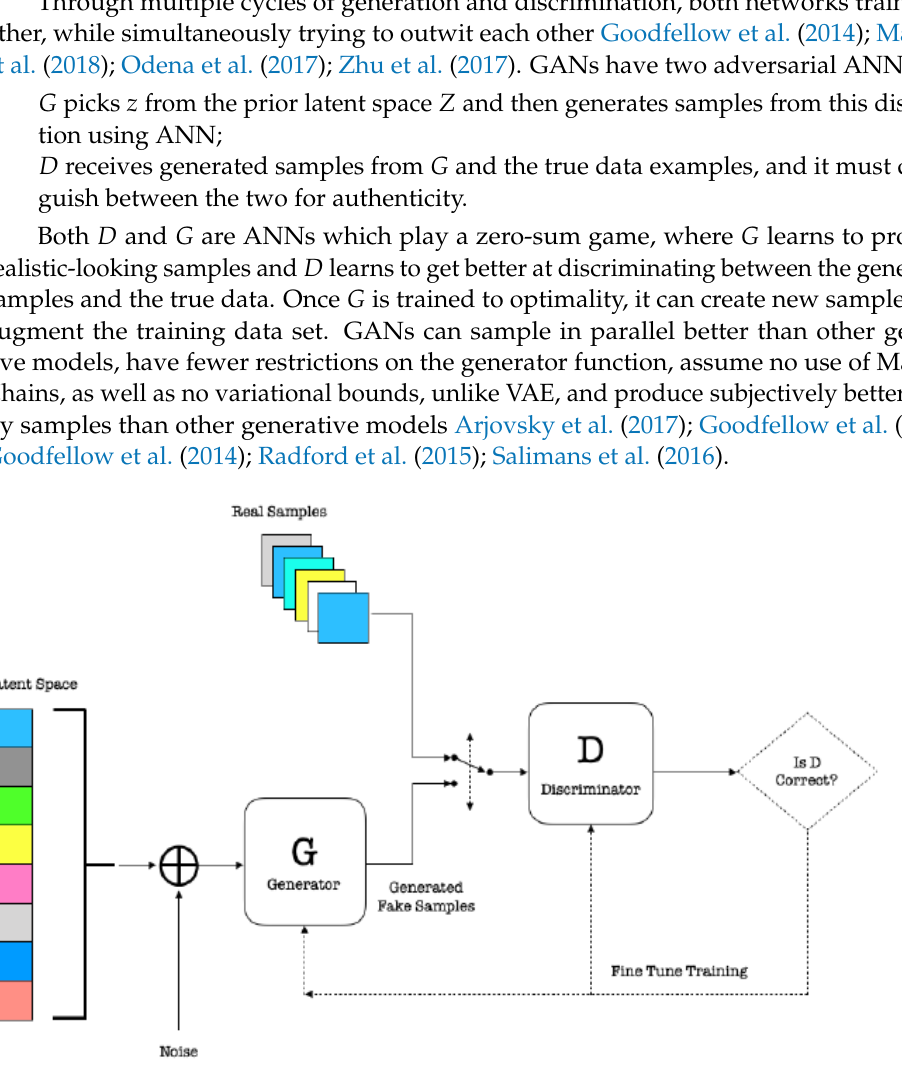
Figure 2. Generative Adversarial Network (GAN)